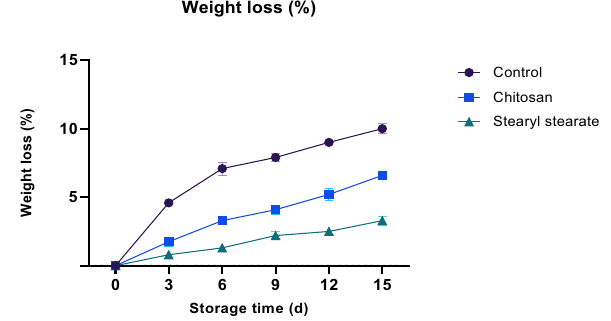
Figure 2. Weight loss of stored tomatoes.